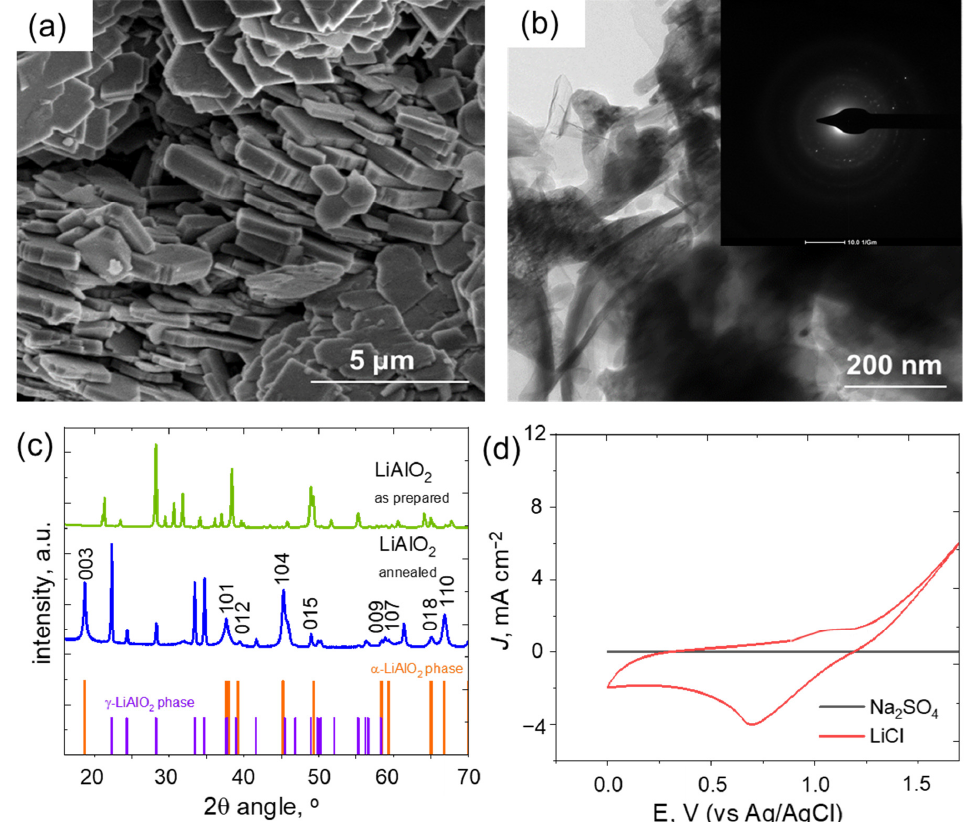
Figure 1. ( a ) SEM image of LiAlO 2 material with a scale bar of 5 µm. ( b ) TEM image of LiAlO 2 at a scale bar of 200 nm, with an inset displaying the SAED pattern. ( c ) X-ray diffraction patterns of the 2 phase, with line pattern representing the standard diffraction pattern of α-LiAlO 2 (long lines, ICDD 98-002-8288) and γ-LiAlO 2 (short lines, ICDD 98-002-3815). ( d ) J –E polarization